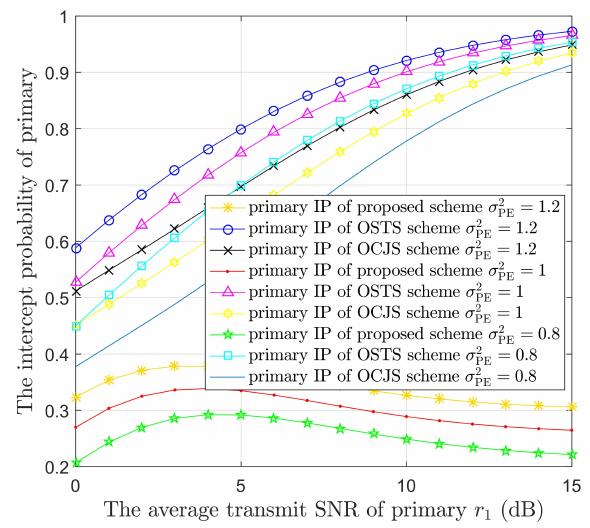
Figure 7. The IPs of the PUs versus the average transmit SNR of primary ( r 1 ) in the three protocols with different channel coefficient ( σ 2 ) PE